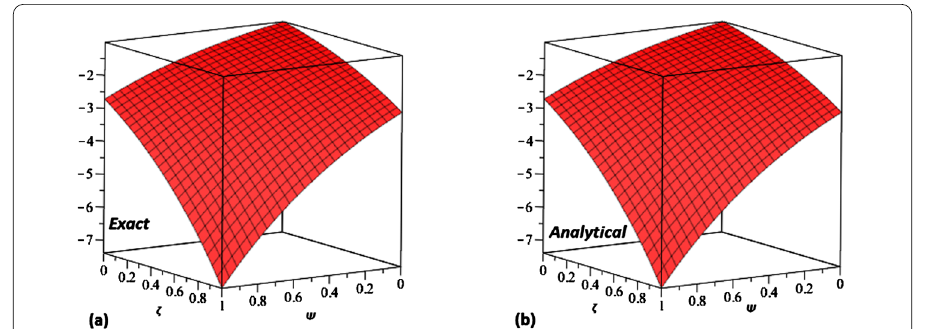
Figure 3 The μ -solution graph of example 2, ( a ) exact solution and ( b ) ETDM solution at δ = 1